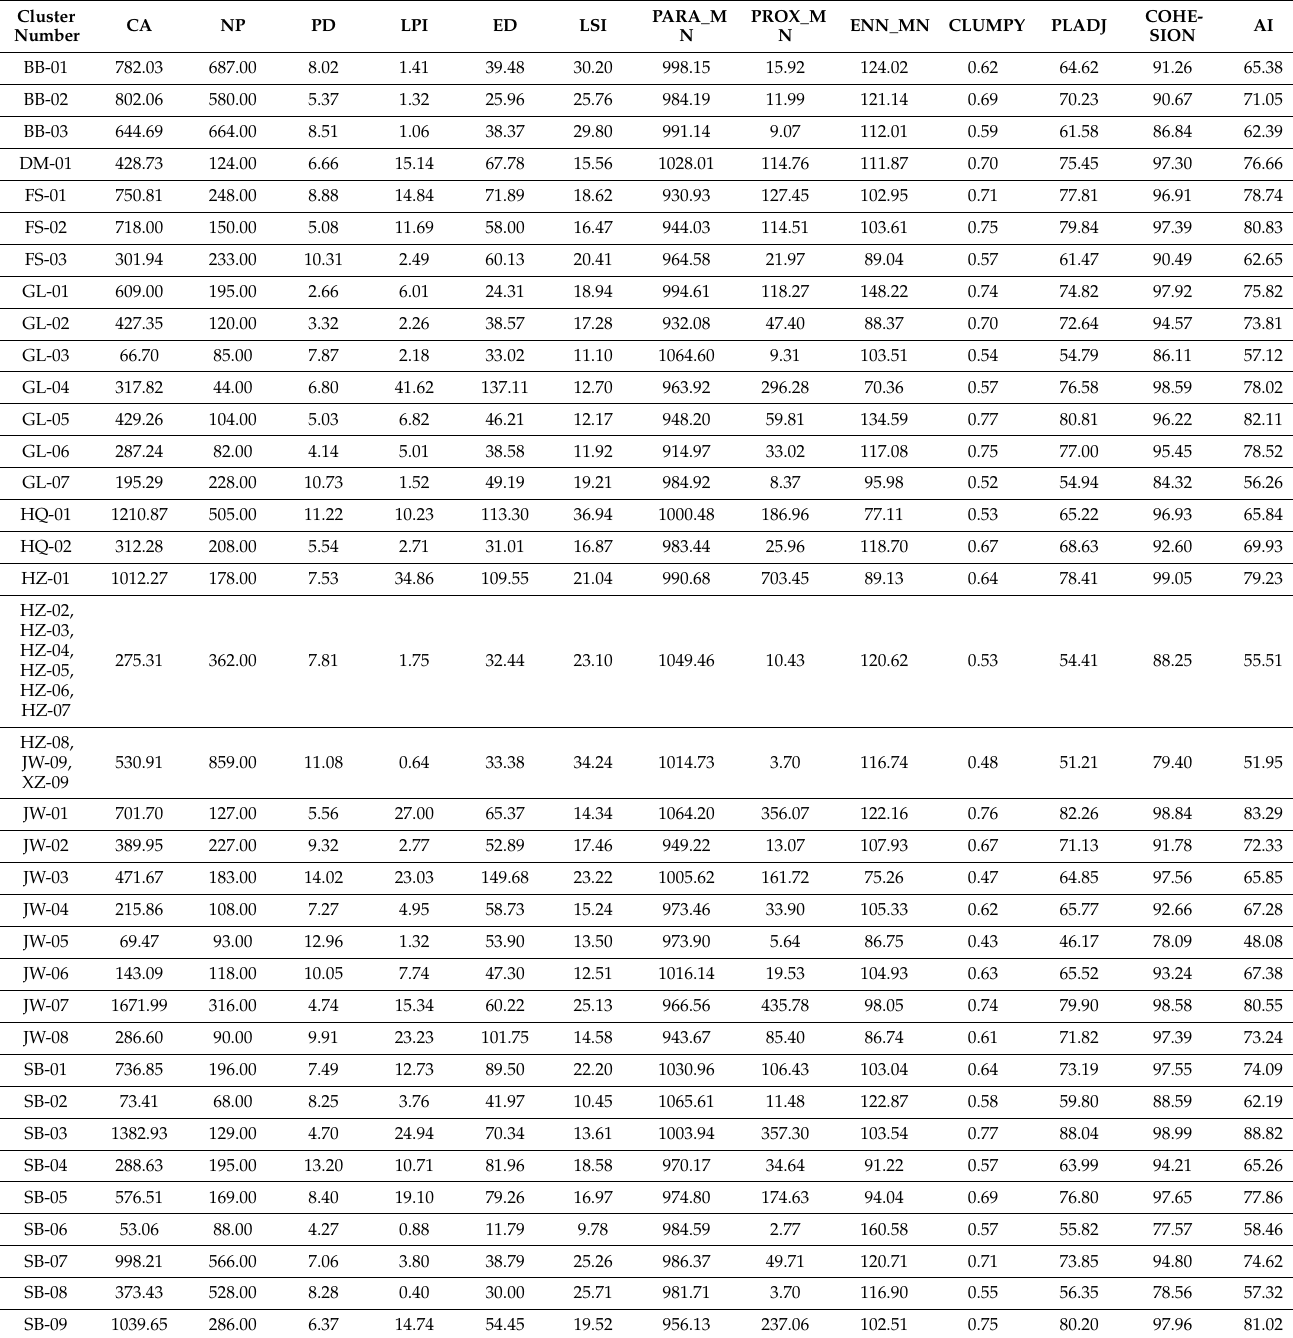
Table A1. The result of landscape spatial index